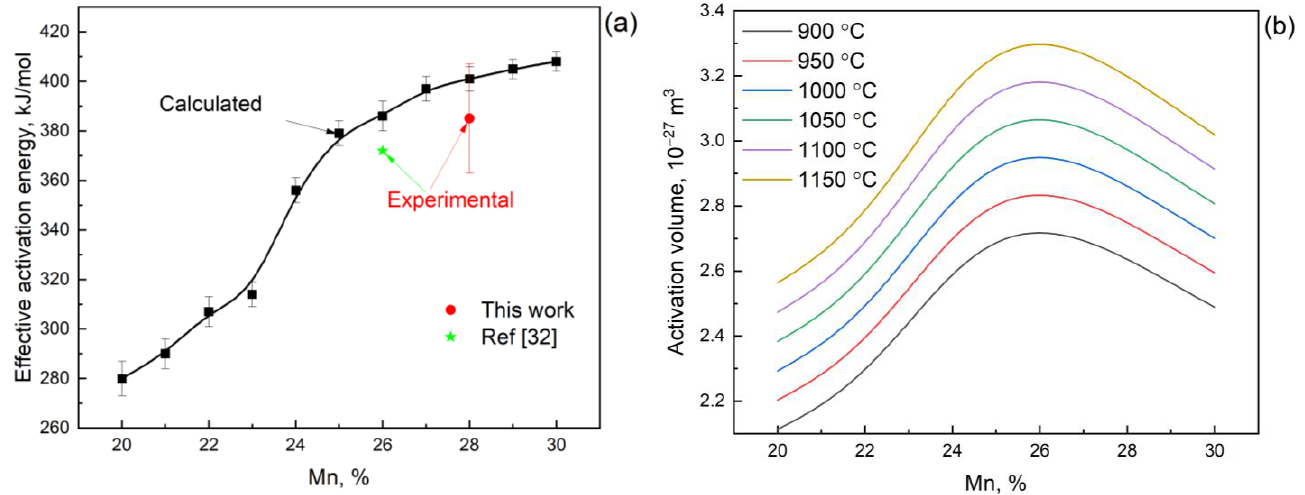
Figure 9. Dependence of the EAE ( a ) and activation volume ( b ) on the Mn content in the Fe – xMn – 8Al – 1C steel at a true strain of 0.7. 8Al–1C steel at a true strain of